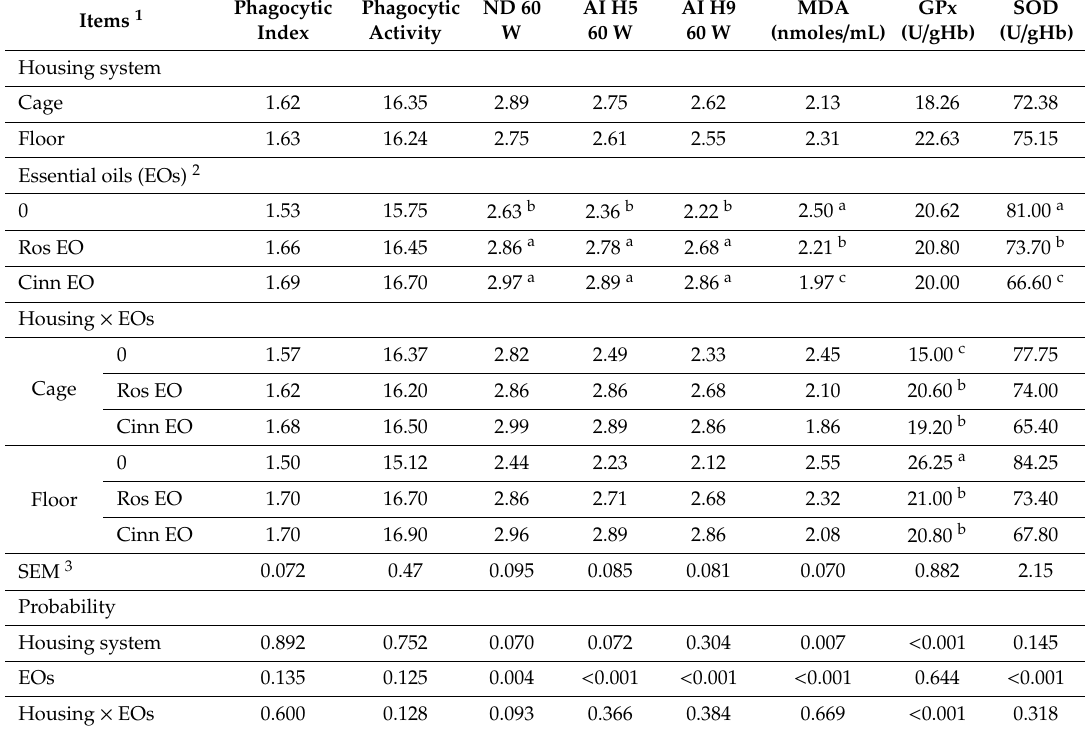
Table 9. Immunity and antioxidant parameters of laying hens as a ff ected by di ff erent housing systems, essential oils and their interaction during the